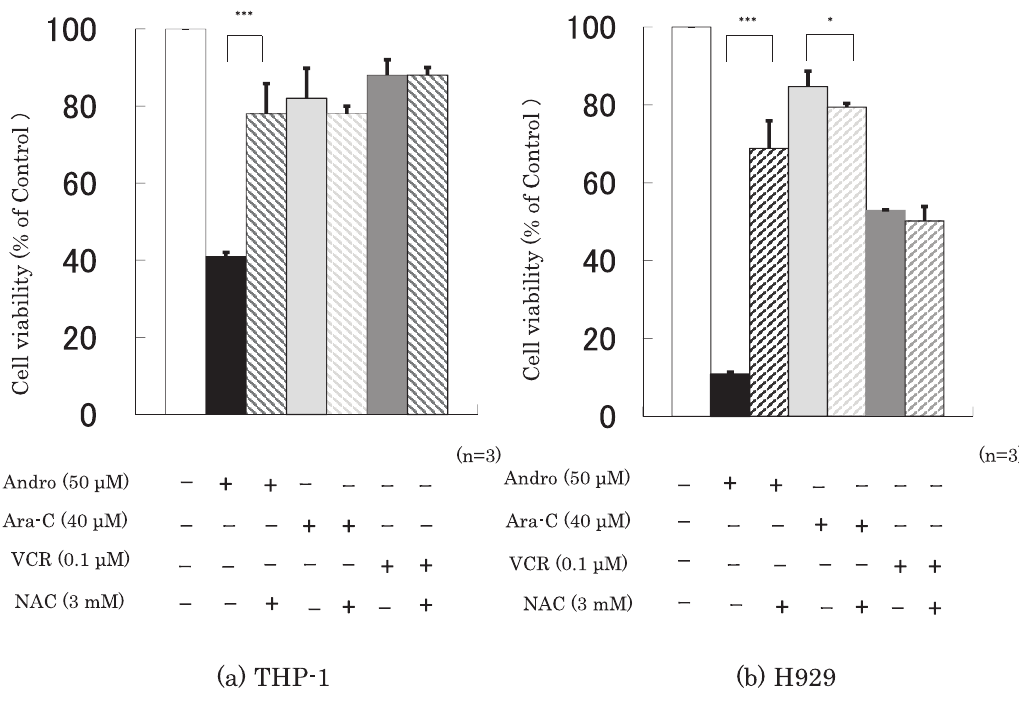
Figure 7. NAC largely reduces Andro ’ s effects on cell viability but has little impact on the effects of Ara-C and VCR. Cell viability was measured after 24 h treatment with Andro, Ara-C, or VCR of THP-1 (a) and H929 (b) cells in the presence or absence of the ROS production inhibitor NAC. The y-axis values represent the optical density (550 nm) in comparison with the control (set as 100%) as measured by MTT